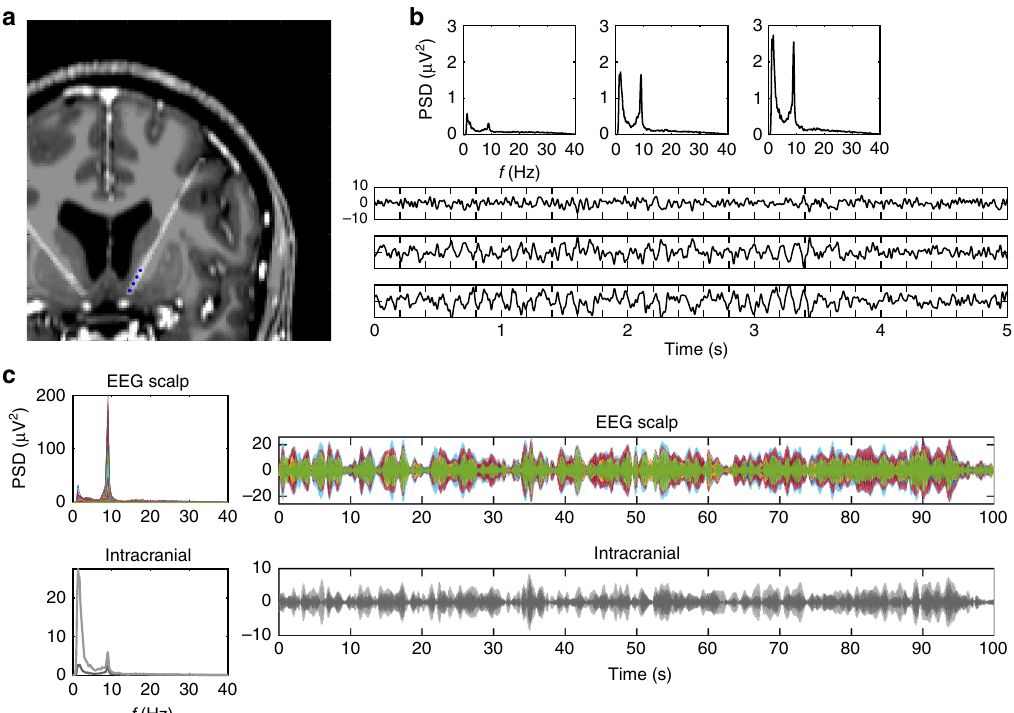
Fig. 1 Electrode implantation and electrophysiological recordings in the OCD patient. a MRI overlaid with post-op CT scan, illustrating the location of the intracranial DBS electrodes indicated as blue dots, i.e., the nucleus accumbens, at its transition with the internal capsule in this case. b Power spectral density (PSD) and exemplary time courses are displayed from three bipolar derivations at the top, middle and lowest pair of the four intracranial electrode contacts. Note that the two most dorsal electrodes are located in the internal capsule. c PSD of scalp EEG and intracranial recordings were used to select individual alpha peak frequency (left panel). Exemplary time courses of alpha envelopes after narrow-band fi ltering showing similarities and differences of scalp and intracranial signals (right panel). Different colors are displaying different recording electrodes; light/dark gray colors correspond to left/right hemispheric implantation sites. All time courses are scaled in µ